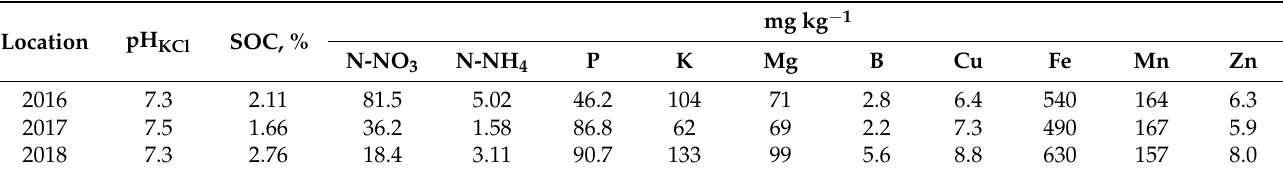
Table 1. Soil properties before sugar beet sowing in years